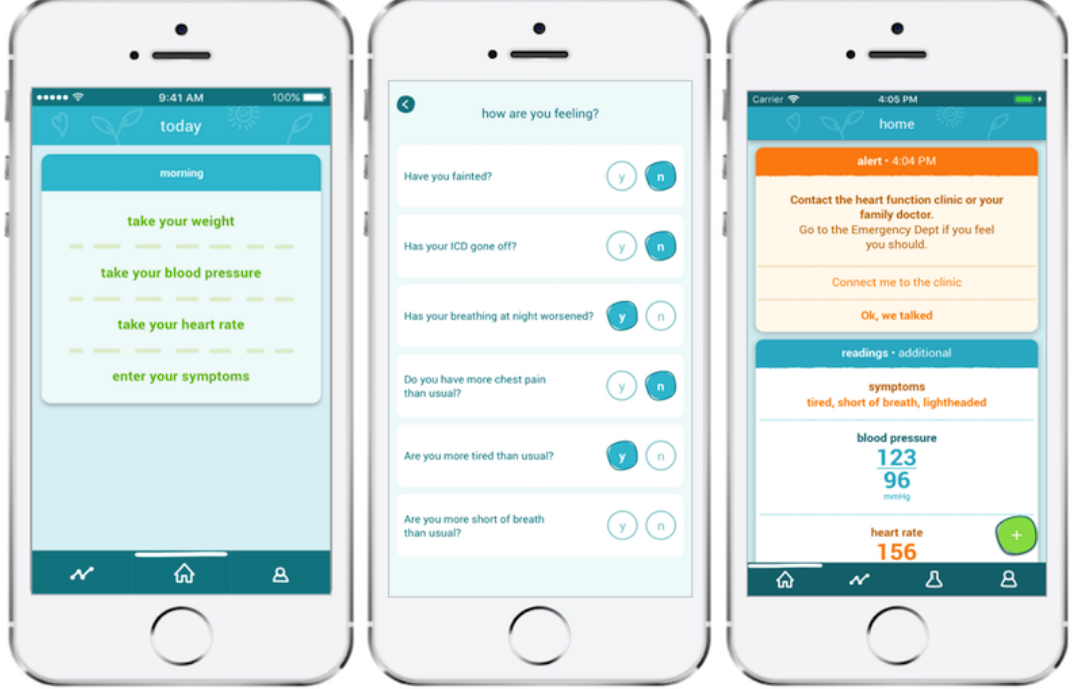
Figure 1. Screens of the Medly app showing the incomplete morning card with required readings, the symptoms questionnaire, and personalized self-care feedback after all 4 readings were taken and processed by the